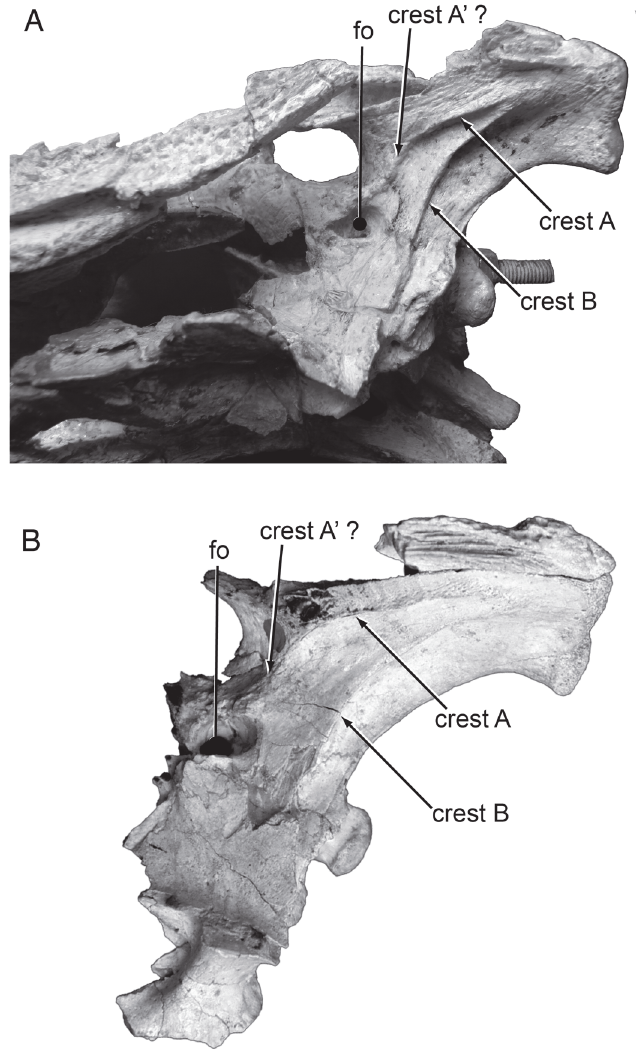
Fig 12. Lateral braincase morphology in Paralligatoridae. A , Shamosuchus ulanicus (= Paralligator gradilifrons ) (PIN 3140-502), left side; B , S . tersus (= Paralligator gradilifrons ) (PIN 3141-501), left side. Abbreviations: fo, foramen